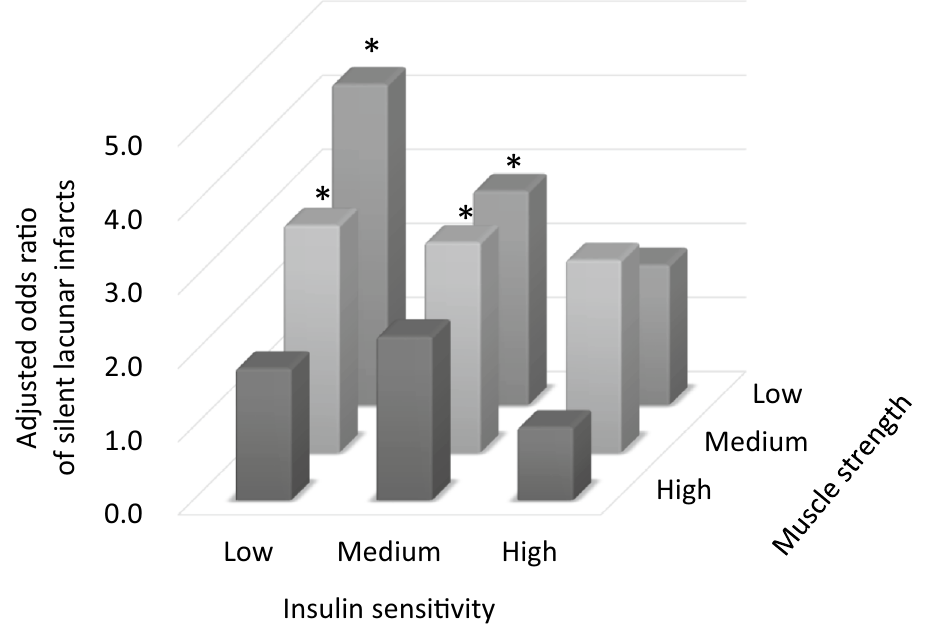
Figure 2. Interaction between insulin sensitivity and muscle strength in relation to silent lacunar infracts. Odds ratios were adjusted for age, sex, smoking, daily physical activity, hypertension, diabetes, dyslipidemia, and cardiovascular disease. *p < 0.05 compared with the category with the highest insulin sensitivity and muscle